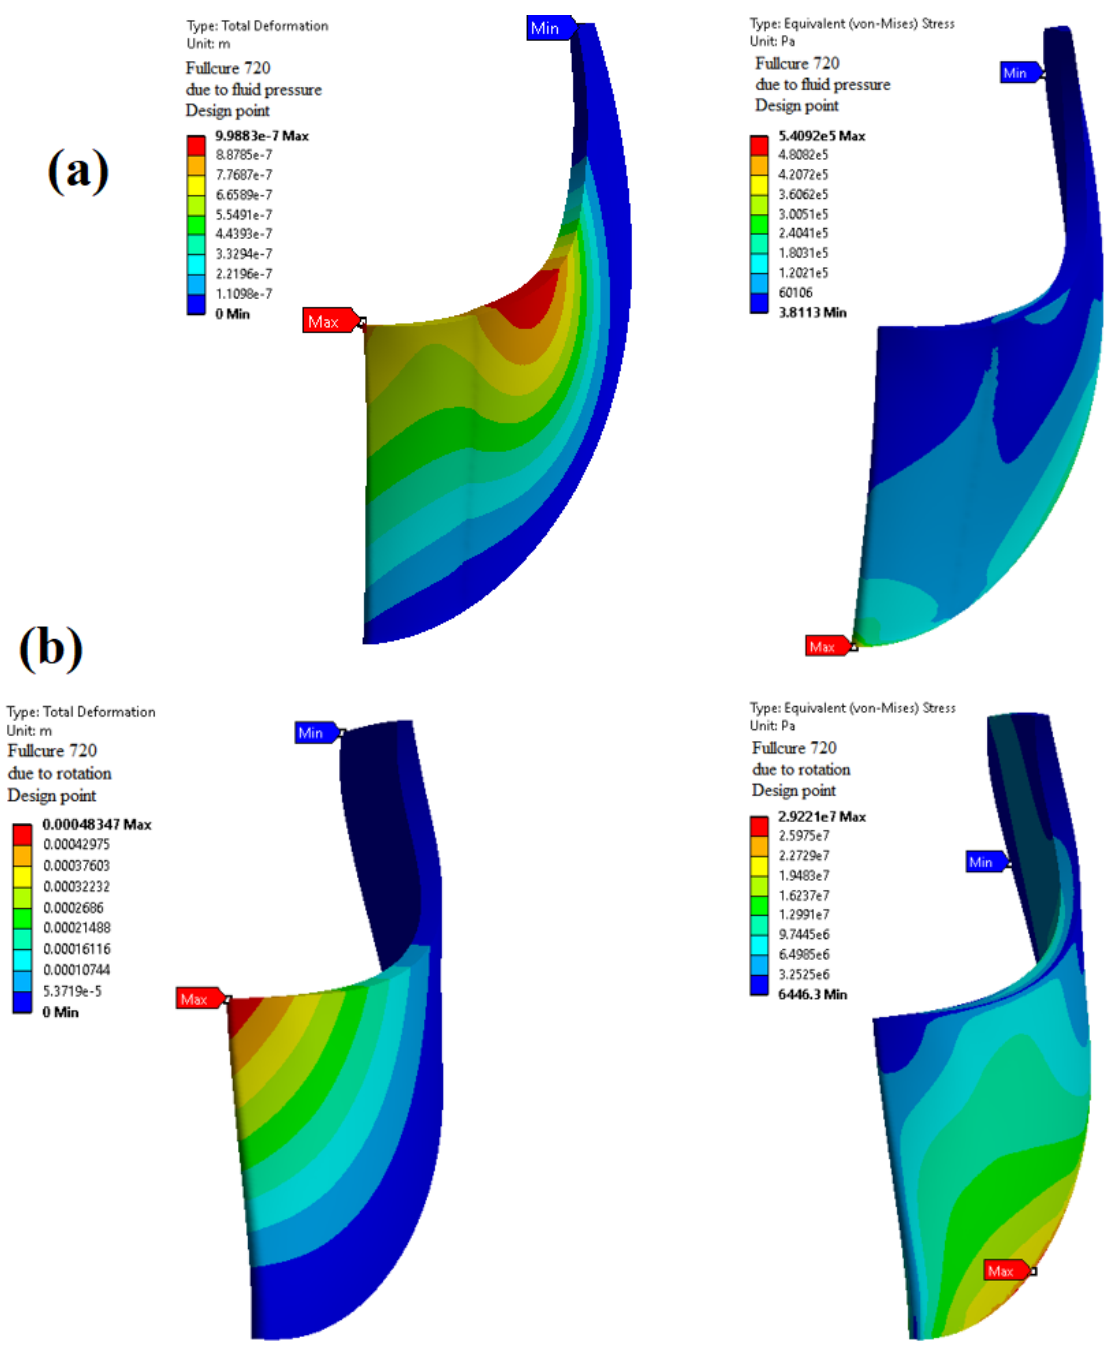
Figure 28. Distributions of von Mises and displacement due to fluid pressure ( a ) and rotation ( b ), using Fullcure 720. Table 7. Minimum and maximum stresses and total deformations of rotor blades at design and off- design conditions.